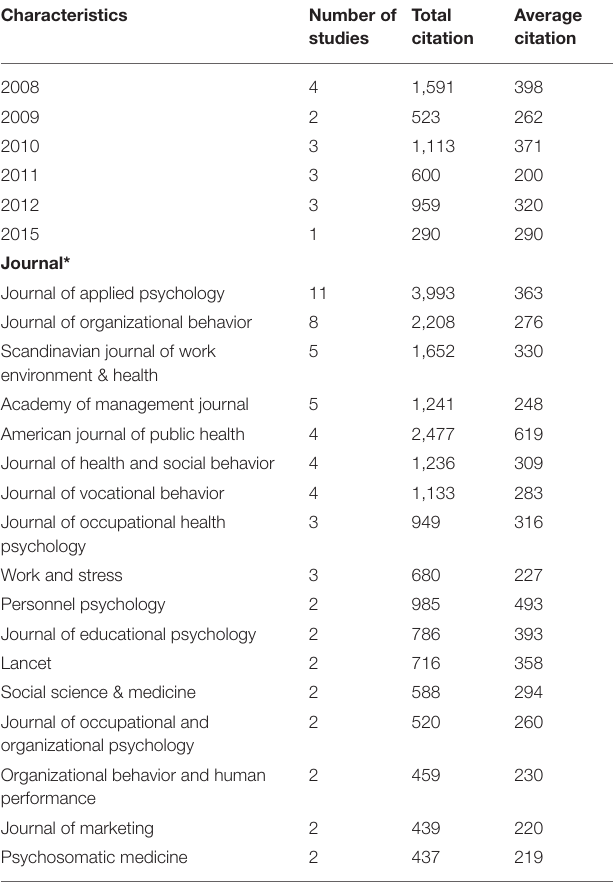
TABLE 1 | Analysis characteristics of the 100 top-cited